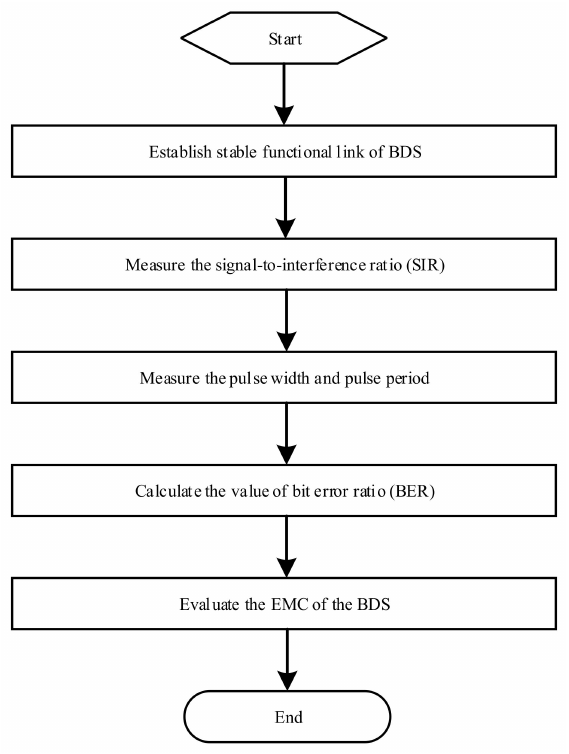
Figure 14. Flow chart of receiver EMC evaluation